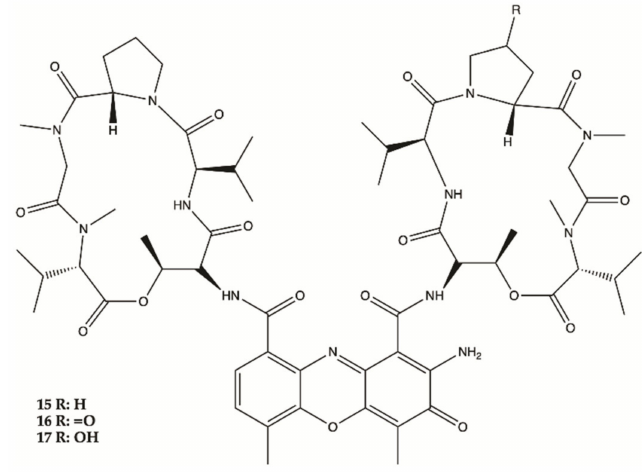
Figure 7. Actinomycins 15 – 17 isolated from sea squirts [37].